Question: Condense the content of this figure into a single sentence.
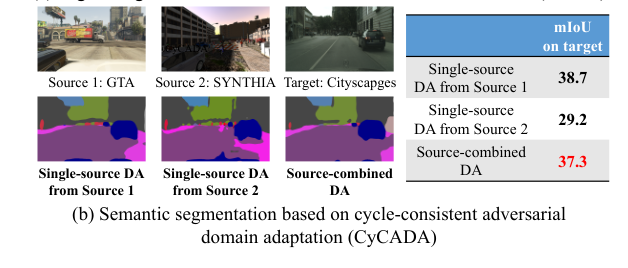
Answer: Examples of domain shift in the multi-source scenario. Simply combining multiple source domains into one source and di- rectly performing SDA does not guarantee better performance com- pared to just using the best individual source.